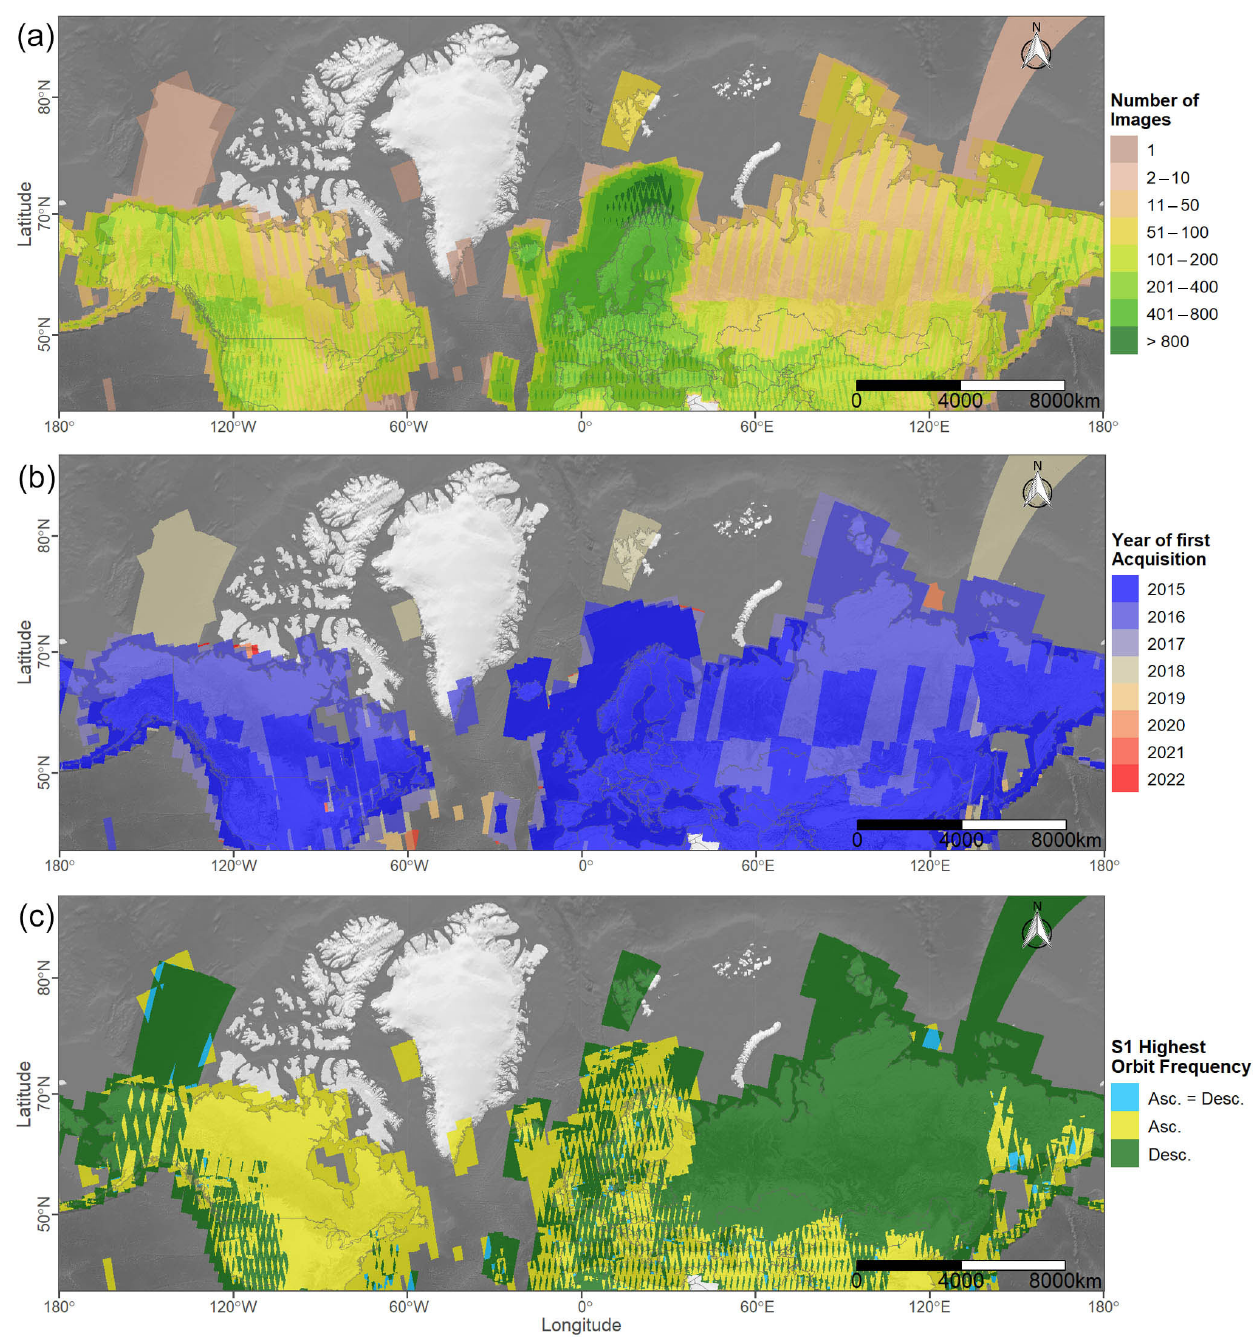
Figure 2. ( a ) Number of available Sentinel-1 (S1) Ground Range Detected (GRD) scenes in Interfero- metric Wide (IW) swath mode since launch and until the end of 2021 for the months June–September; ( b ) Year of first available S1 GRD scene in IW swath mode for the months June–September; ( c ) Orbit with the highest number of available S1 GRD scenes in IW swath mode since launch and until the end of 2021 for the months June–September. A shaded relief by Natural Earth [58] was utilized as a back- ground map. Source of Administrative boundaries: The Global Administrative Unit Layers (GAUL) dataset, implemented by Food and Agriculture Organization of the United Nations (FAO) within the CountrySTAT and Agricultural Market Information System (AMIS)